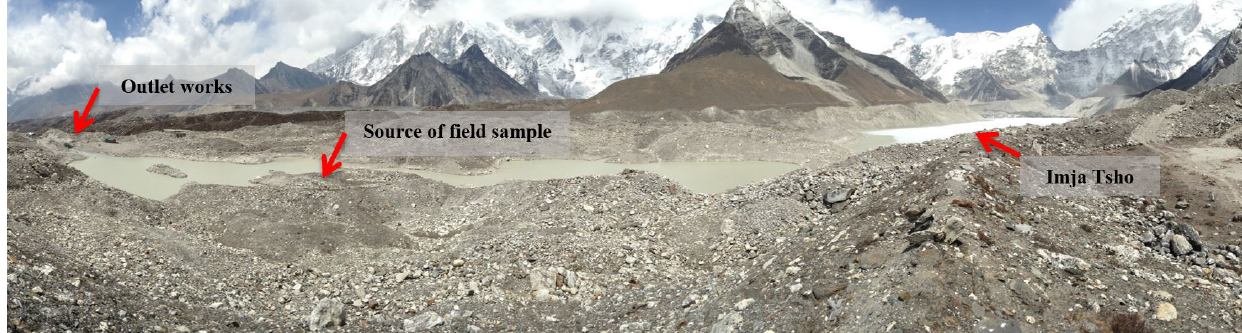
Figure 2. Imja Tsho’s terminal moraine and outlet pond complex showing the lake water (right side of image) flowing westward through a series of ponds to the outlet of the terminal moraine (left side of image) (photo acquired 27 April 2017). The location of a field sample used in this study is also